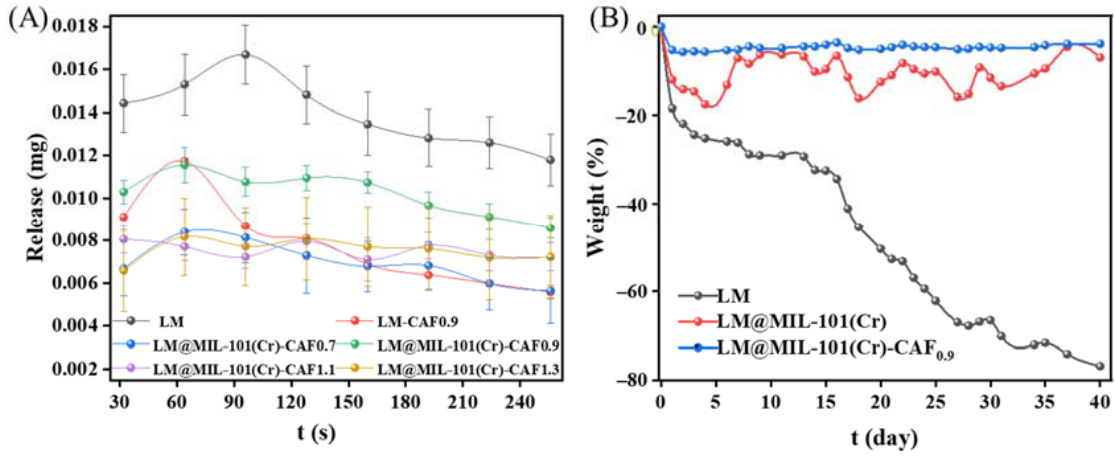
Figure 5. ( A ) Heat release and ( B ) storage stability of LM in different systems.